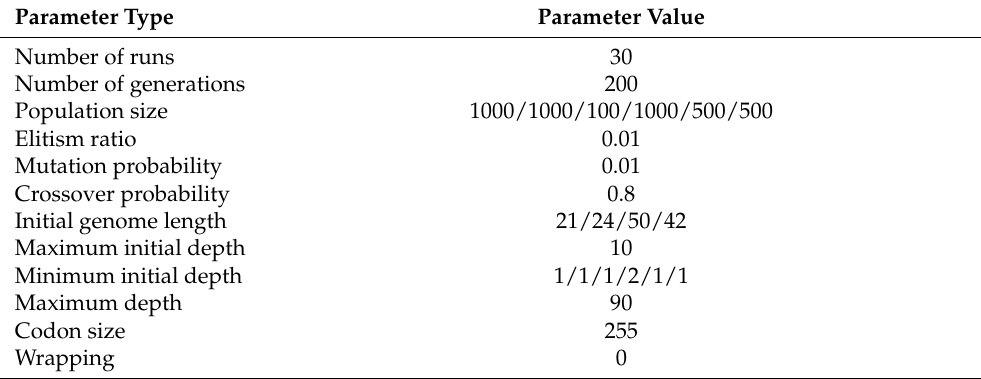
Table 3. Experimental hyperparameters.